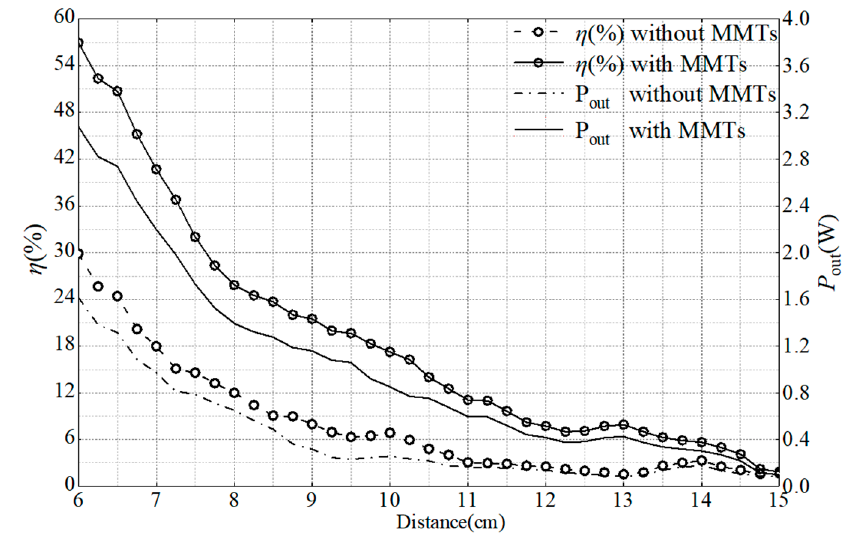
Figure 12. Variation of power and efficiency with different distances between Tx and Rx.